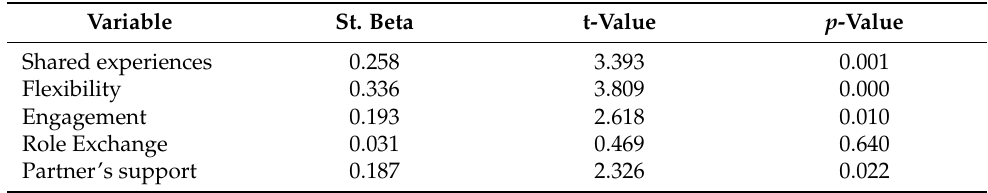
Table 3. Linear regression results of conceptual model test with collaboration as a dependent variable.